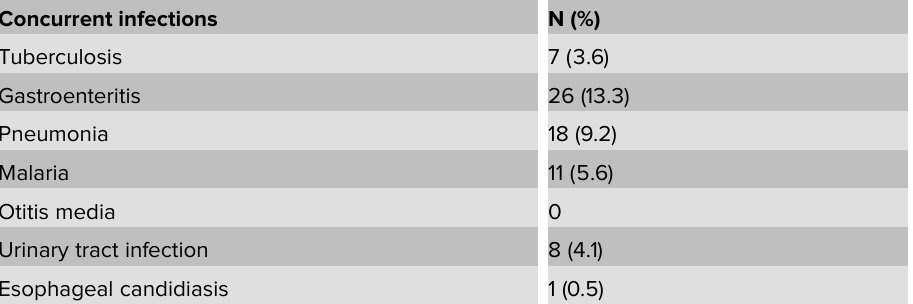
Table 4: Concurrent infections often detected in patients with VL admitted to the TDTH.